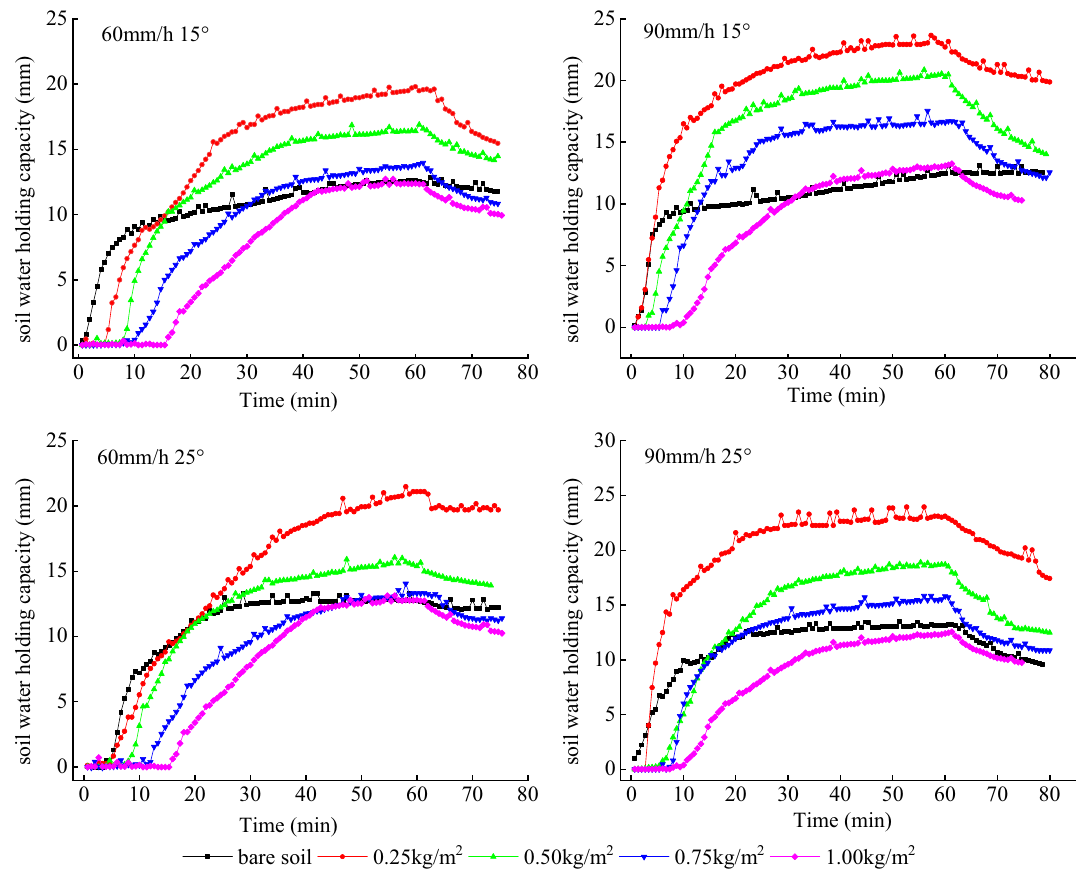
Figure 3. Soil water holding capacity depending on time from start of